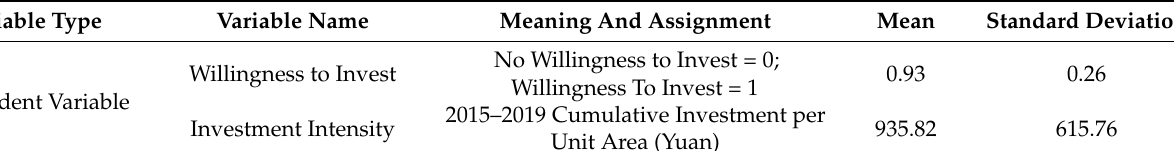
Table 1. Variable definition and descriptive